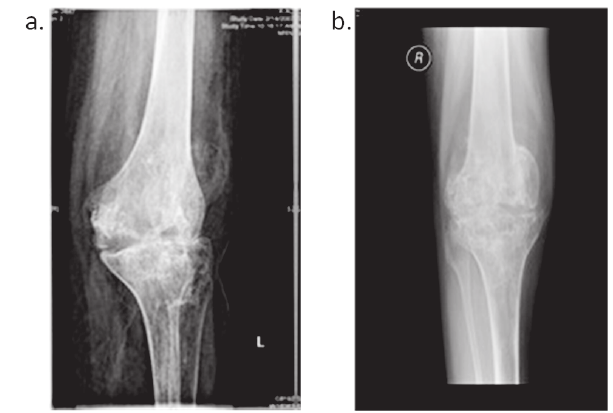
Figure 2. AP left & right knee x-ray shows erosion and